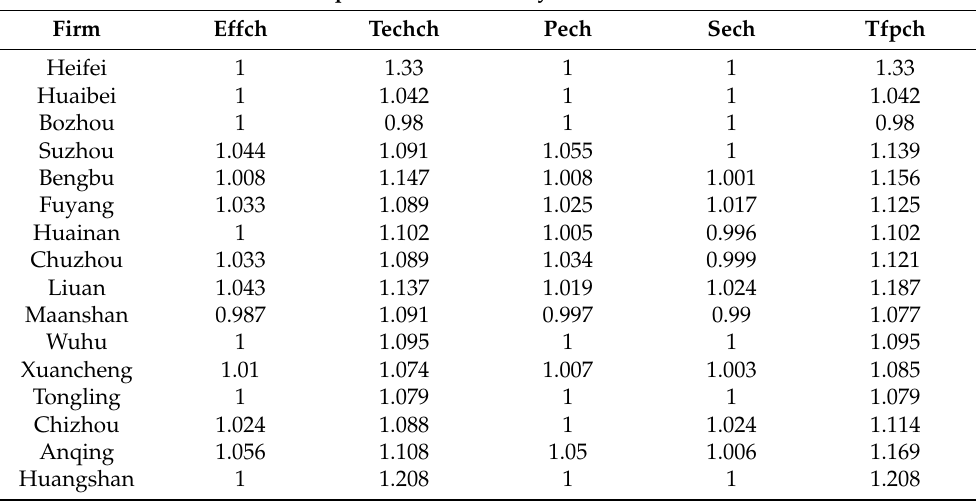
Table 4. Malmquist index and decomposition of eco-efficiency of 16 cities in Anhui Province from 2015 to